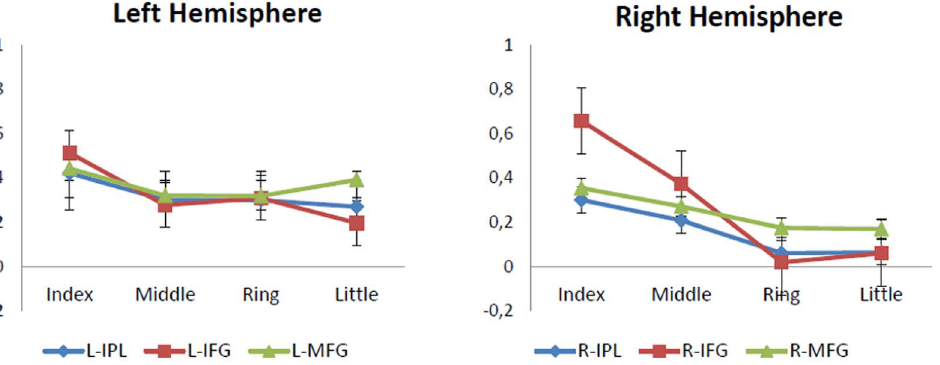
Figure 5. Parameter estimates in parietal and frontal regions of the left and right hemisphere. Graphics show the parameter estimates for each finger movement observation condition in six local maxima within the mirror neuron system. The error bars indicate the standard error of the mean. IPL=Inferior Parietal Lobule; IFG=Inferior Frontal Gyrus; MFG=Middle Frontal Gyrus; L/R=Left/right. MNI coordinates: R-IPL [52 2 42 18]; L-IPL [ 2 46 2 40 22]; R-IFG [40 44 4]; L-IFG [ 2 58 10 8]; R-MFG [48 4 50]; L-MFG [ 2 50 2